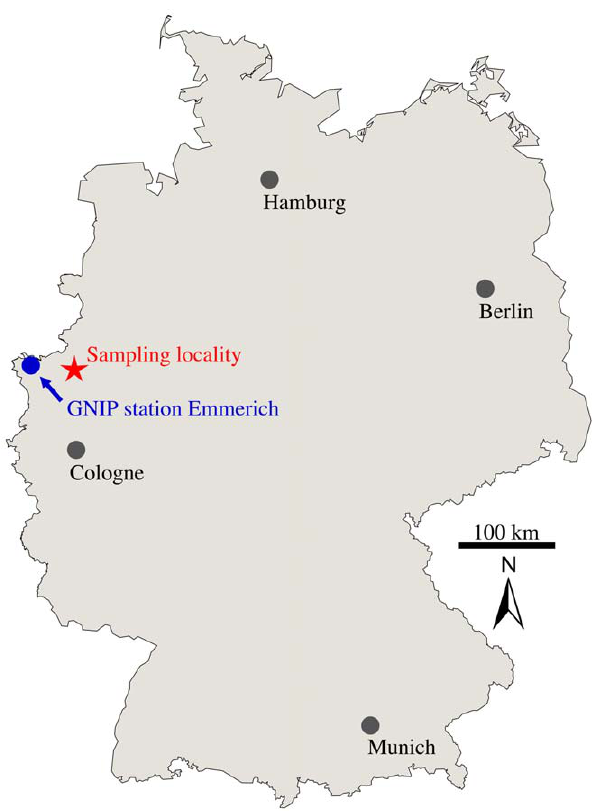
Figure 1. Map showing the sampling locality Rhader Wiesen near Dorsten, North Rhine-Westphalia, Germany (red star) and the closest IAEA-GNIP station to it (blue dot).